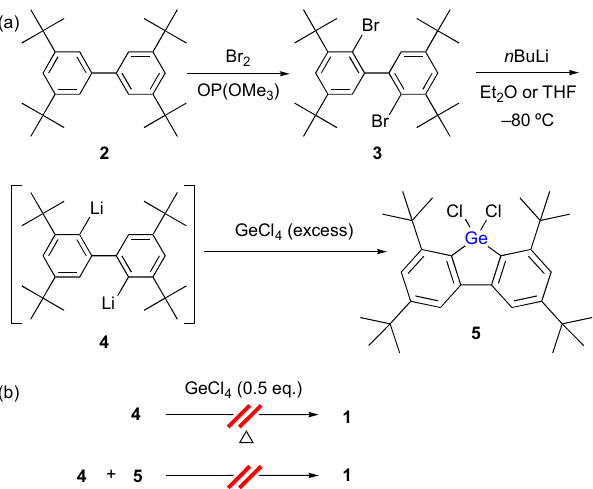
Scheme 1. ( a ) Synthesis of dichlorogermane 5 . ( b ) Attempted synthesis of 1 using conventional substitution reactions with Ge IV substitution reactions with Ge IV species. substitution reactions with Ge IV species.